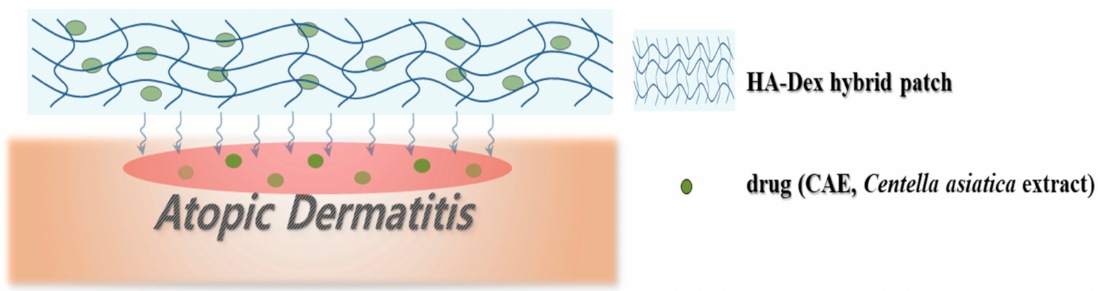
Figure 1. Concept of atopic dermatitis treatment using a Centella asiatica extract (CAE)-loaded hyaluronic acid (HA)-dextran (Dex) hybrid hydrogel